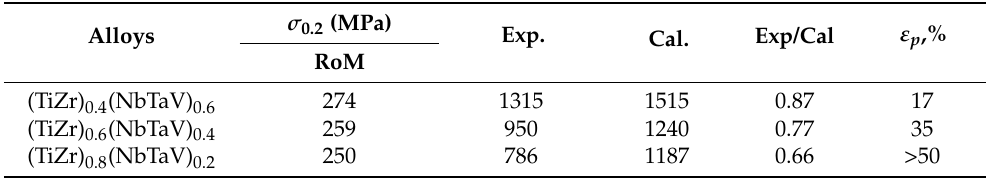
Table 4. Comparison between the calculated yield strength and the experimental value; the values by rule of mixing and compressive strain are also listed. σ 0.2 (MPa) Exp. Alloys